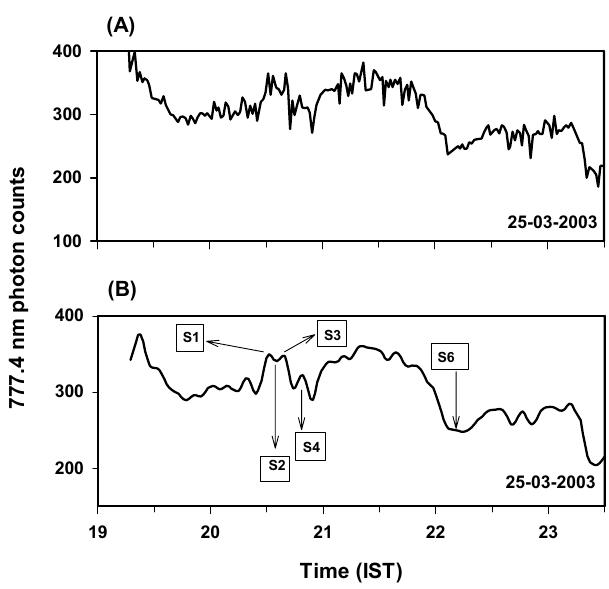
Fig. 3. ( A ) Nocturnal variation of 777.4-nm intensity on 25 March 2003 as observed by the photometer and ( B ) reconstructed variation after the removal of high frequency components in the frequency